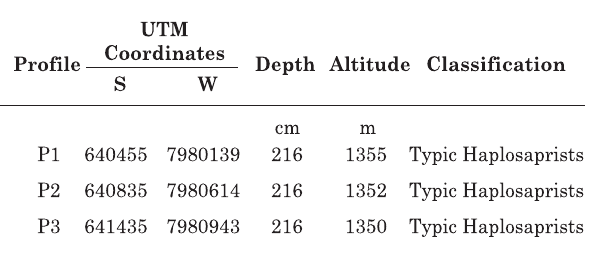
Table 1. Location, depth, altitude, and classification of sampled